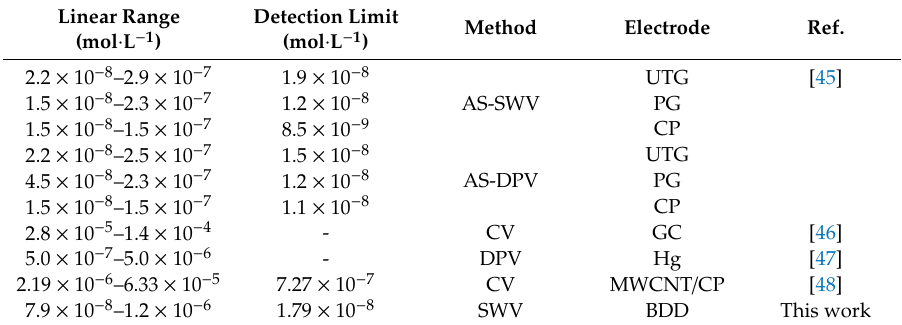
Table 2. Comparison of linear range and detection limits for itraconazole to di ff erent